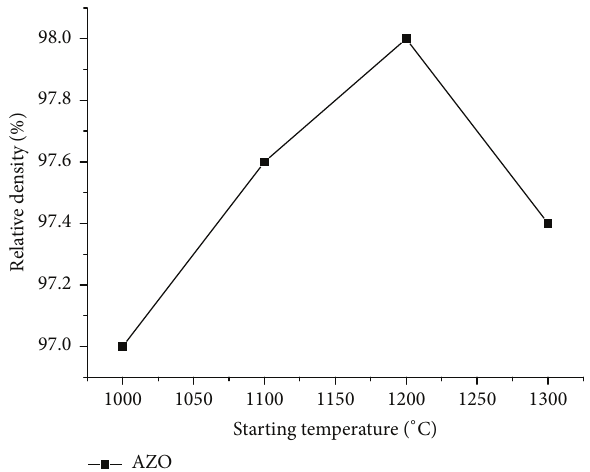
Figure 11: Relative densities of AZO targets as a function of change rate of microwave